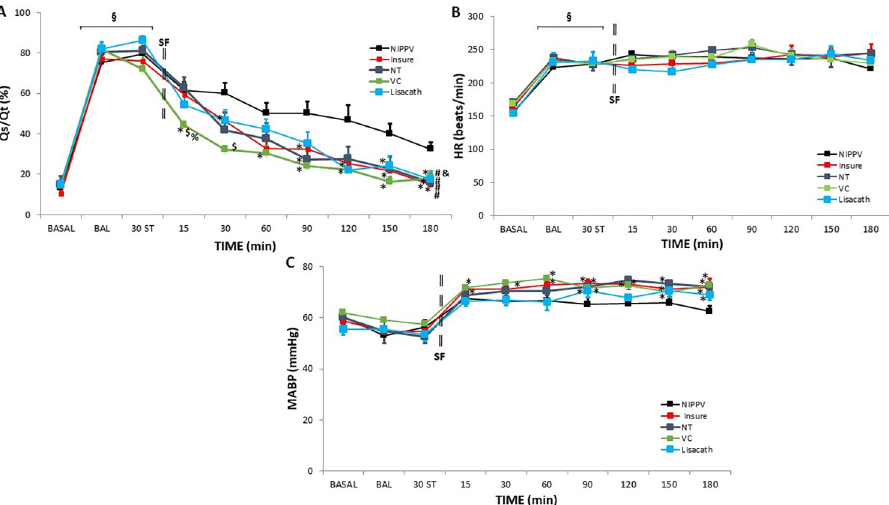
Fig 4. Intrapulmonary shunt ratio (Qs/Qt), heart rate (HR) and mean arterial blood pressure (MABP) in newborn piglets with bronchoalveolar lavage-induced respiratory distress treated with nasal intermittent-positive- pressure-ventilation (NIPPV) without SF therapy or with SF therapy, using the INSURE-like method, LISA with a nasogastric tube (NT), LISA with a vascular catheter (VC) or LISA with the LISAcath 1 catheter during the 180-min treatment period. Mean Qs/Qt (A), HR (B) and MABP (C) values in the NIPPV (black), INSURE (red), NT (dark-blue), VC (green) and LISAcath (blue) groups. (§)p < 0.05 vs baseline; ( * )p < 0.05 vs NIPPV group, ($)p < 0.05 vs INSURE group and (%)p < 0.05 vs NT group (one-way-ANOVA); (#)p < 0.05 vs NIPPV alone group and (&)p < 0.05 vs INSURE group (two-way-ANOVA). Values = mean ± SEM. ST: stabilization.